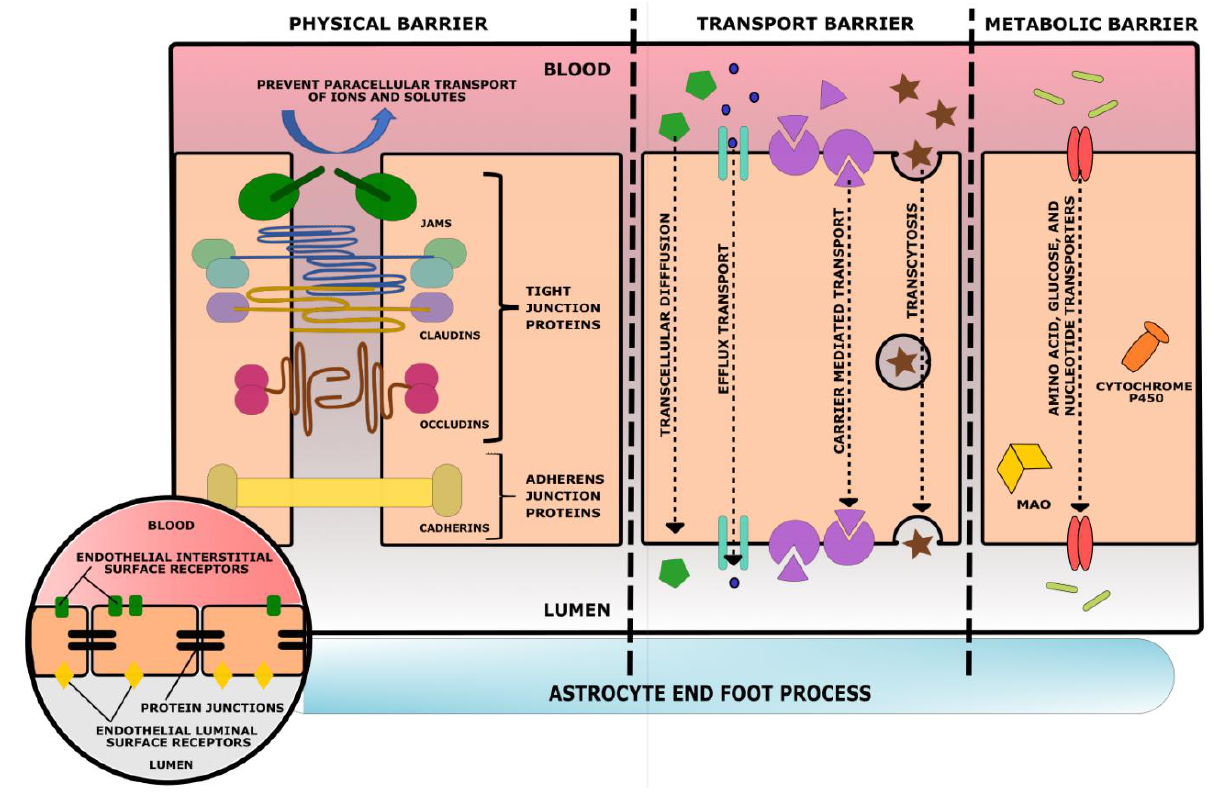
Figure 36. The barriers of the BBB.